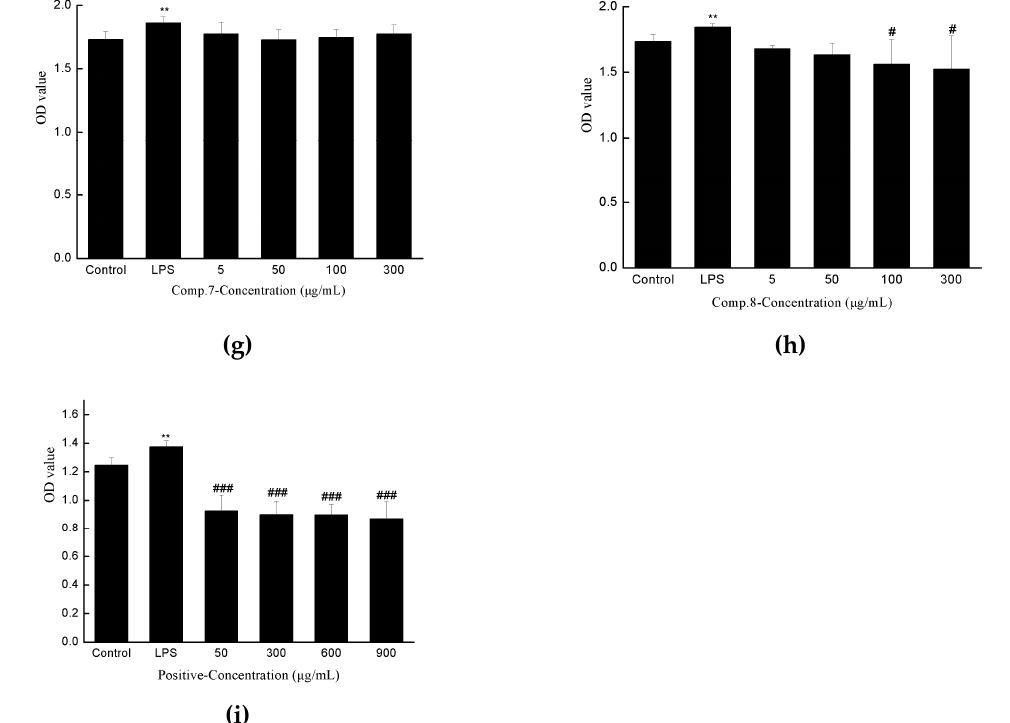
Figure 7. Inhibitory activity of compound 1 ( a )– 8 ( h ) and positive control ( i ) on the proliferation of LPS-activated HSC-T6.